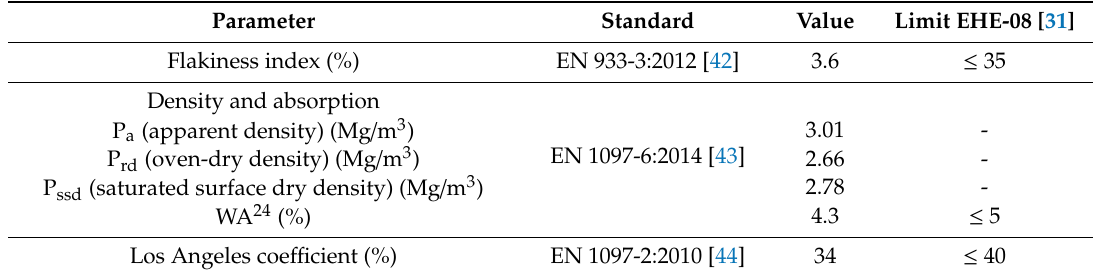
Table 4. Physical and mechanical characterization of the coarse natural aggregates.